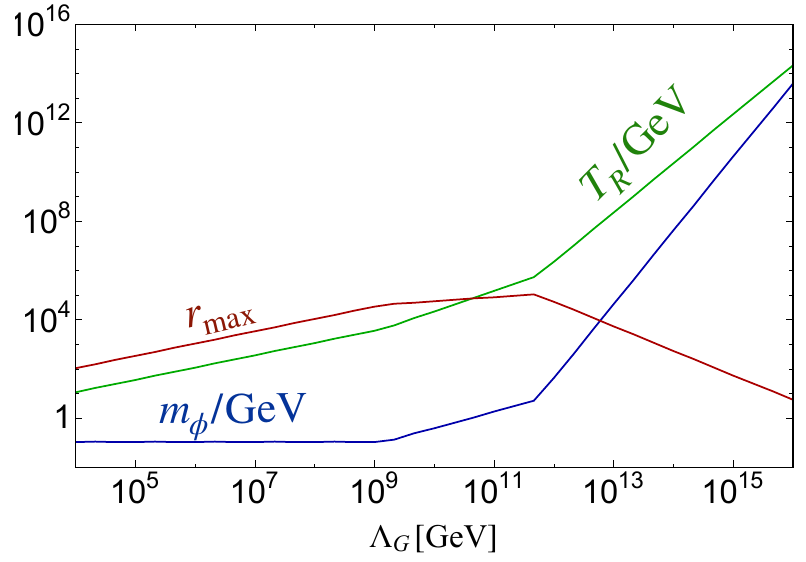
Figure 4 . The maximal r by varying Λ G [red line]. The line satisfies the inequalities of (3.1), (5.5), (5.3), (5.8), and (5.13). The corresponding reheating temperature and inflaton mass are also shown in green and blue solid lines,